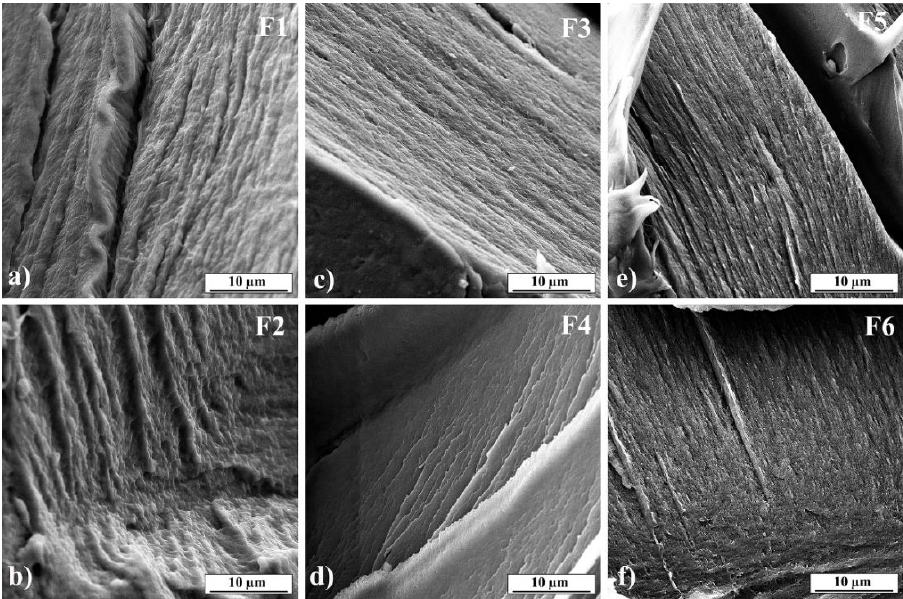
Figure 4. SEM images of 3D printed films: ( a ) F1, ( b ) F2, ( c ) F3, ( d ) F4, ( e ) F5, ( f ) F6.